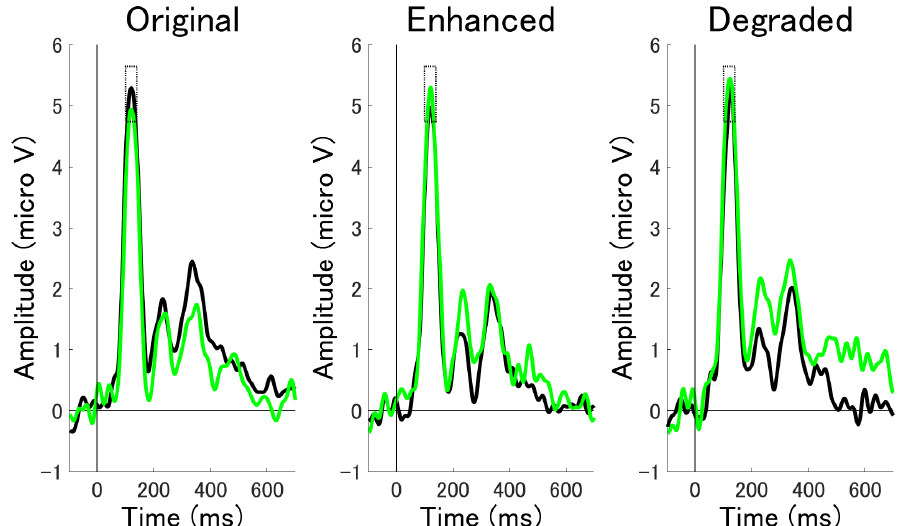
Figure 3. ERP waveforms recorded in each condition at right occipital sensor. The black and green lines represent ERP waveforms for self and other familiar faces, respectively. The rectangles drawn by dotted lines represent time windows used for mean amplitude measurement of P100.